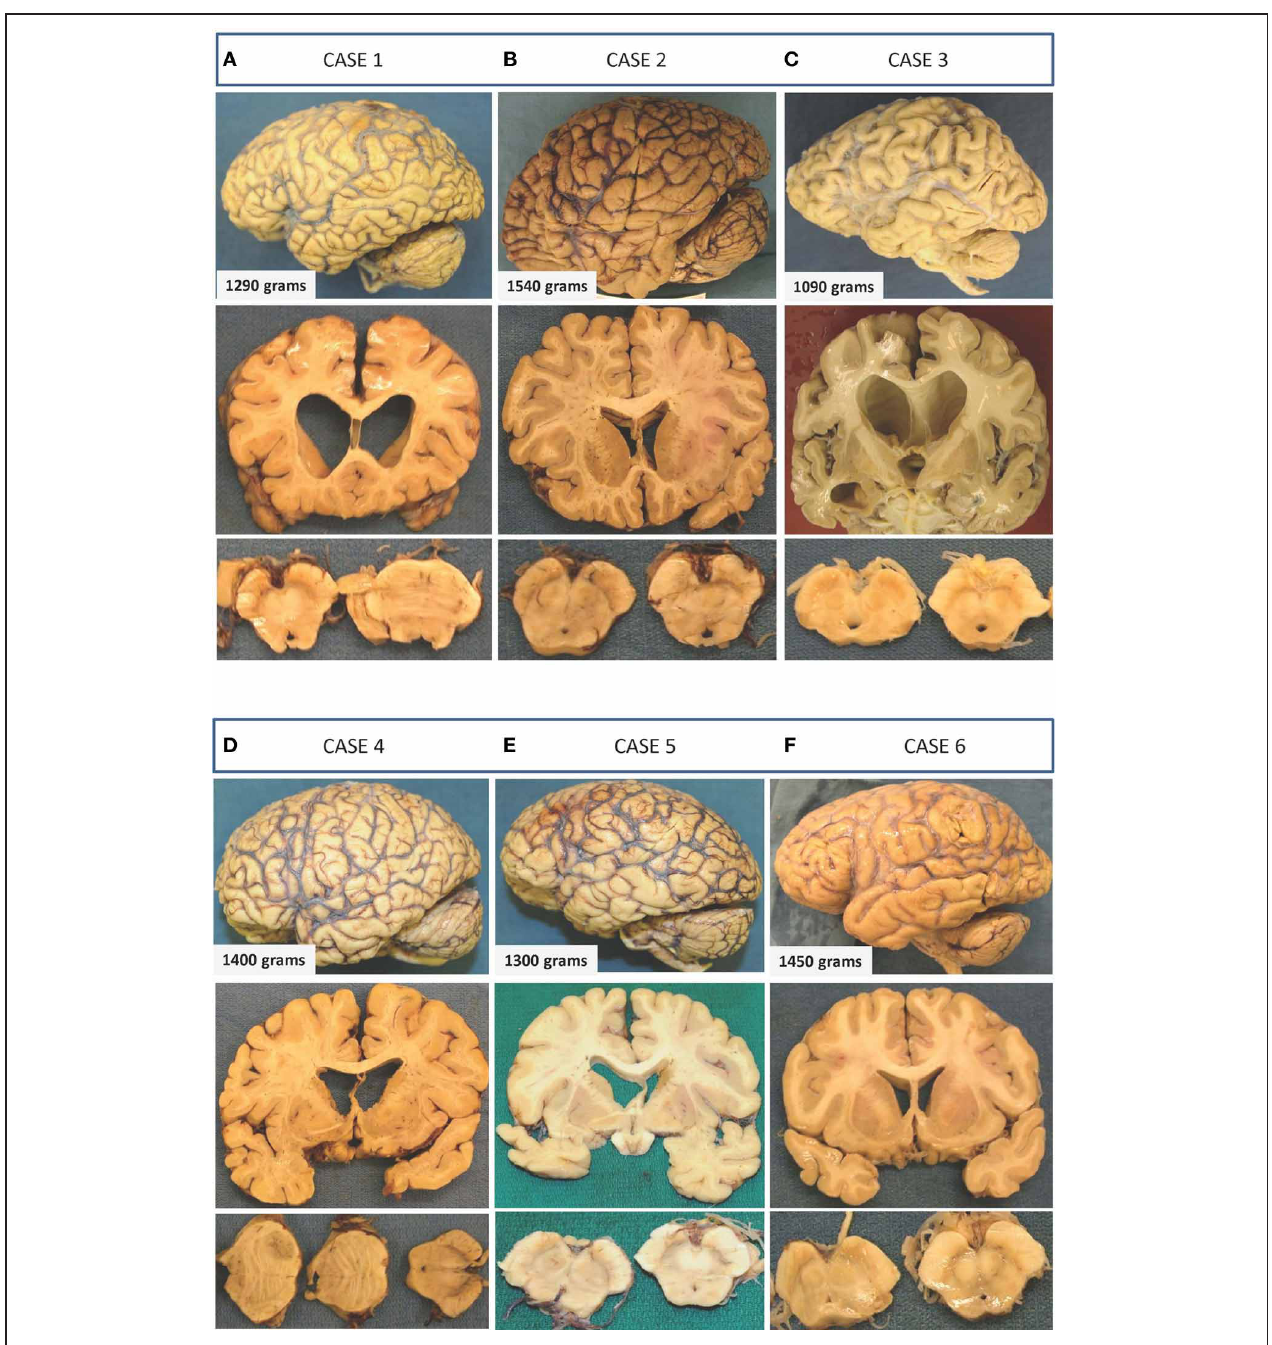
FIGURE 1 | Gross macroscopic findings on neuropathological examination. Selected examples from each case are presented as three vertical panels with lateral views of the unsectioned brain (upper panel), coronal sections through various parts of the cerebrum (middle panel), and axial sections through the brainstem (lower panel). (A) Case 1: There is mild-to-moderate atrophy with ventricular enlargement and cavum septi pellucidi. Thinning of the corpus callosum and mild depigmentation of the substantia nigra is also evident. (B) Case 2: Unsectioned brain, ventricles, and sections of the midbrain and substantia nigra appear within normal limits with no apparent evidence of neurodegeneration. (C) Case 3 : Preferential mild-to-moderate atrophy